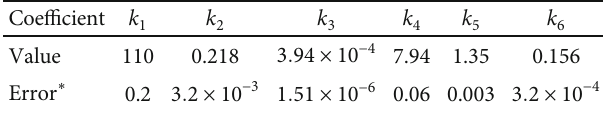
Table 3: Optimal fi tting values of the coe ffi cients in Equation (10).